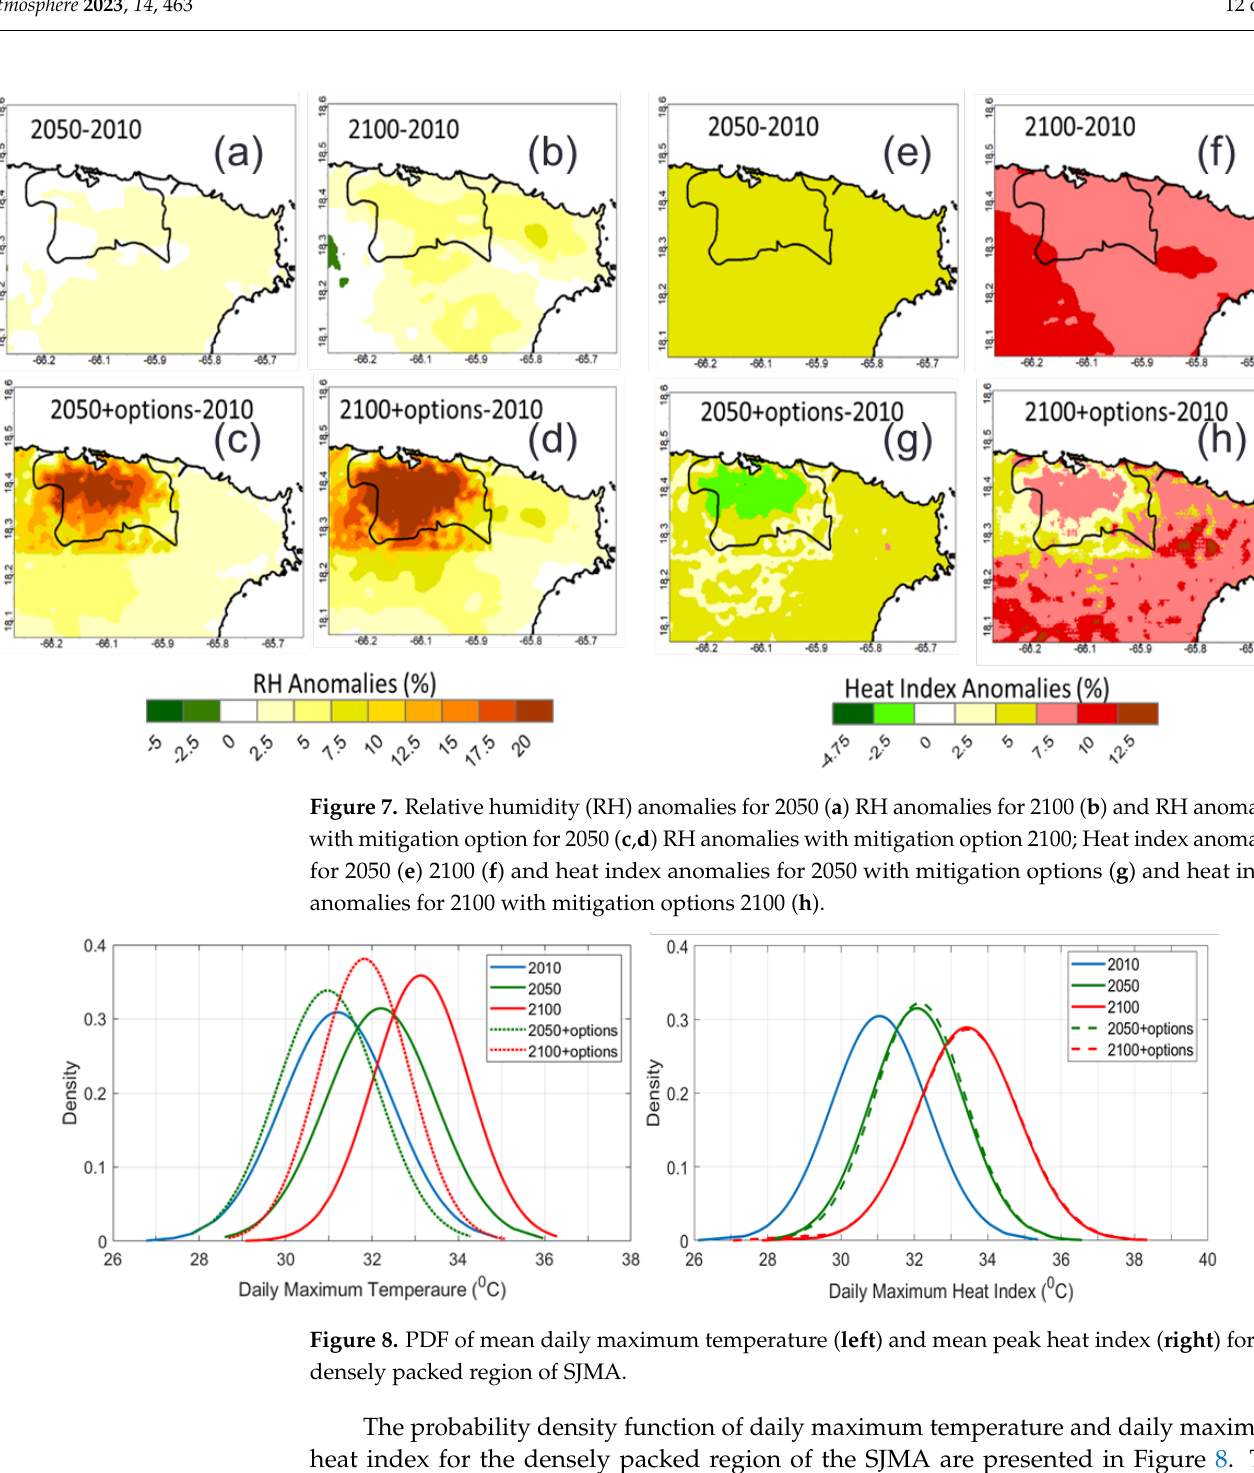
Figure 7. Relative humidity (RH) anomalies for 2050 ( a ) RH anomalies for 2100 ( b ) and RH anoma- lies with mitigation option for 2050 ( c ) and ( d ) RH anomalies with mitigation option 2100; Heat index anomalies for 2050 ( e ) 2100 ( f ) and heat index anomalies for 2050 with mitigation options ( g ) and heat index anomalies for 2100 with mitigation options 2100 ( h ).